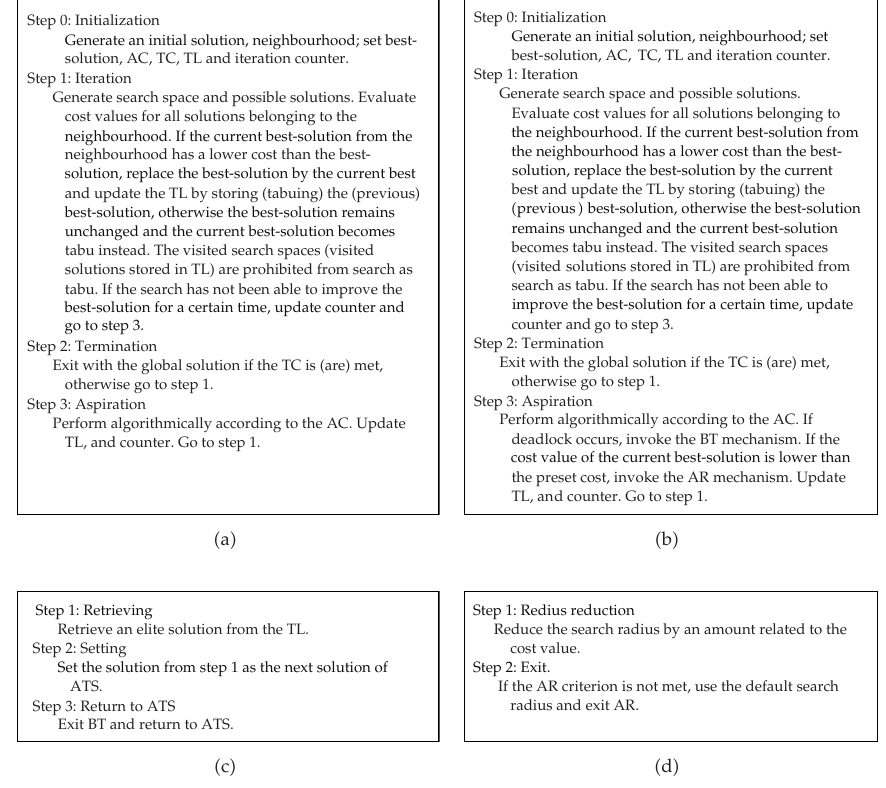
Figure 1: Generic algorithms of the TS and the ATS: (cid:4) a (cid:5) generic TS algorithms, (cid:4) b (cid:5) generic ATS algorithms, (cid:4) c (cid:5) the BT mechanism of the ATS, and (cid:4) d (cid:5) the AR mechanism of the